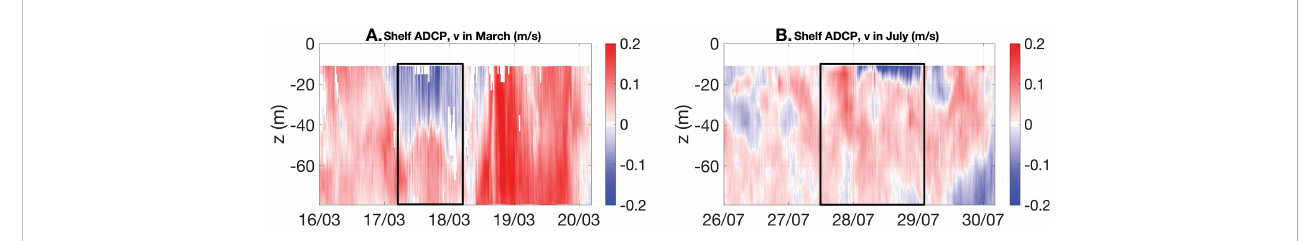
FIGURE 4 Meridional current (m s – 1 ) measured by the shelf ADCP: (A) in March and (B) in July. The boxes indicate upwelling